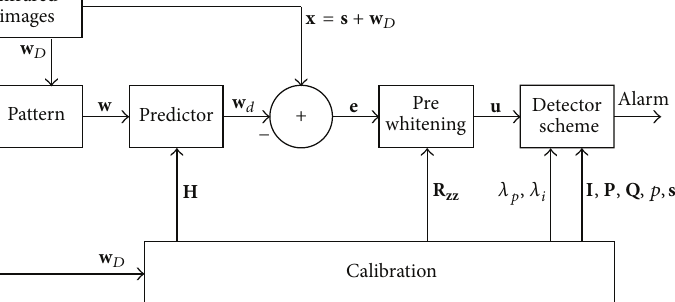
Figure 1: Sensor scheme.